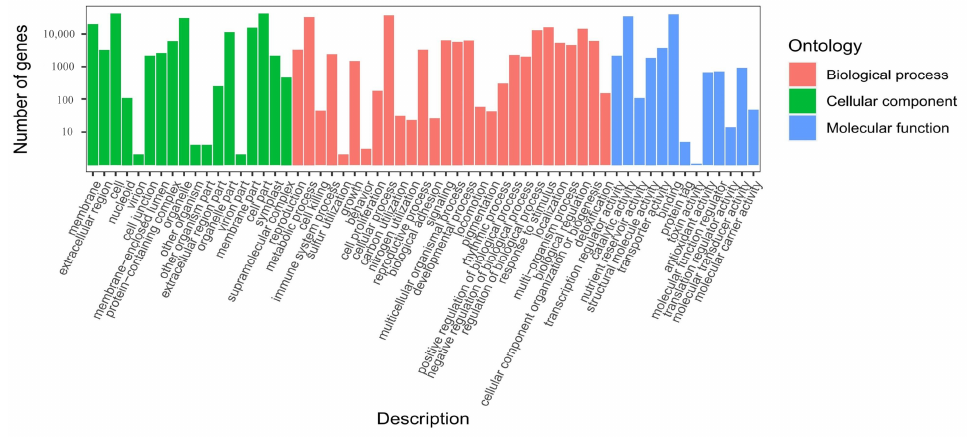
Figure 4. GO classifications of assembly of unigenes in P. koraiensis under different supplementary lights.